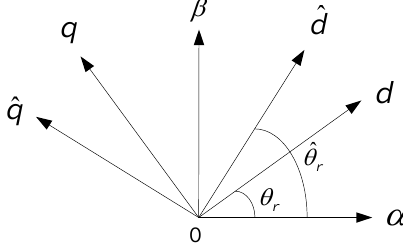
Figure 3. Relationship between the three coordinate systems.